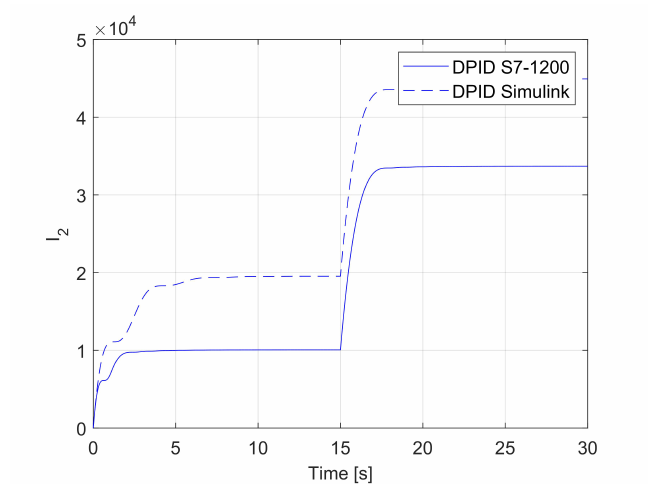
Figure 7. Cost functions J 2 for the DPID realization by PLC and by the Simulink simulator.